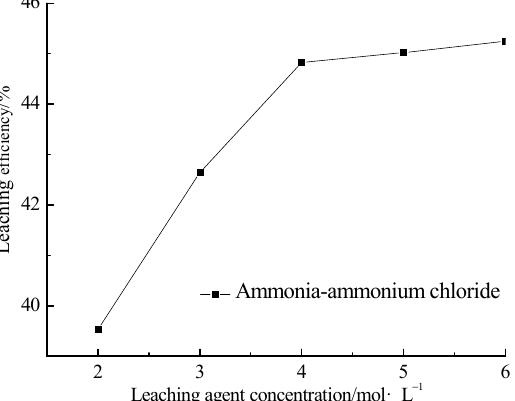
Figure 4. Effect of leaching agent concentration on zinc extraction.